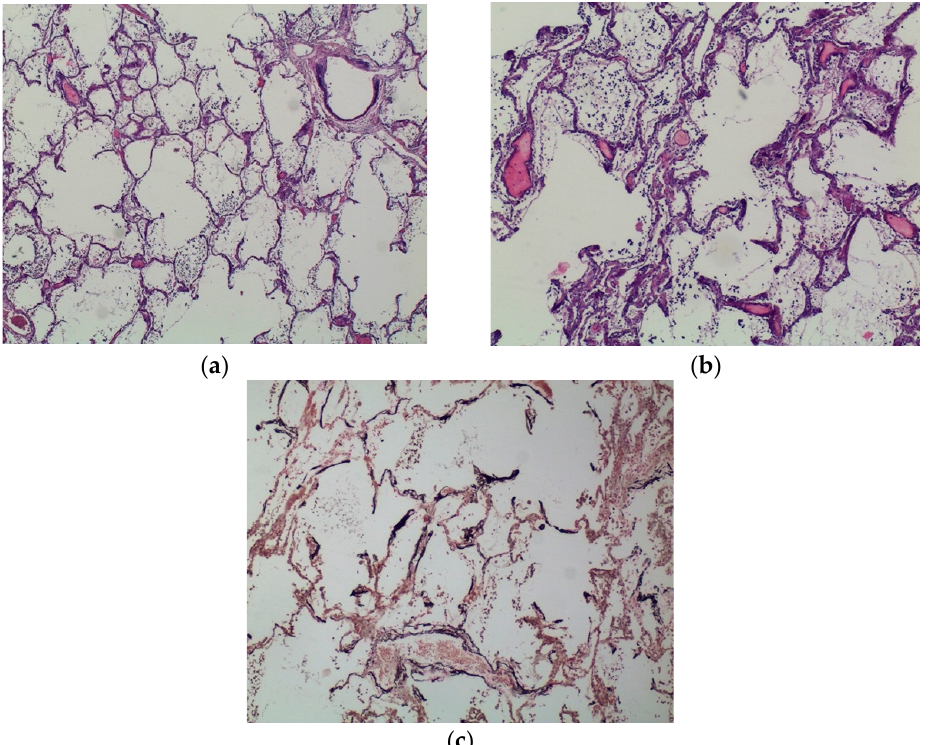
Figure 5. Lungs. ( a ) H&E staining—magnification 120×. Alveolar pattern and bronchial architecture are preserved although the septal walls are slightly thickened and basophilic. Calcium deposition can be spotted in a small bronchus basal membrane. ( b ) H&E staining—magnification 240×. The walls of small blood vessels and alveoli are particularly affected by metastatic calcification with a heavy diffuse deposition of calcium salts resulting in thickened, basophilic, and vaguely hyaline alveolar walls. The alveolar cavities contain few leukocytes and scarce amount of amorphous material. ( c ) IHC von Kossa stain—magnification 120×. Calcium salts deposition appears as dark stain because of its affinity for silver nitrate.